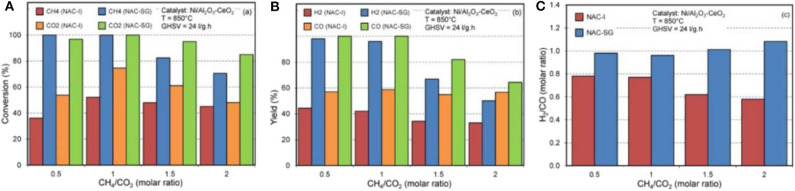
Effect of synthesis method on (A) feed conversion, (B) products yield, and (C) H2/CO molar ratio in a product at different feed ratios over Ni/Al2O3-CeO2 nanocatalyst. Reproduced from Aghamohammadi et al. (2017) with permission from Molecular Catalysis.